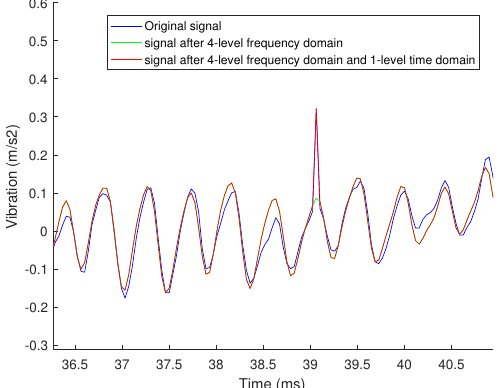
Figure 12. The results of decomposition and reconstruction with different sparse